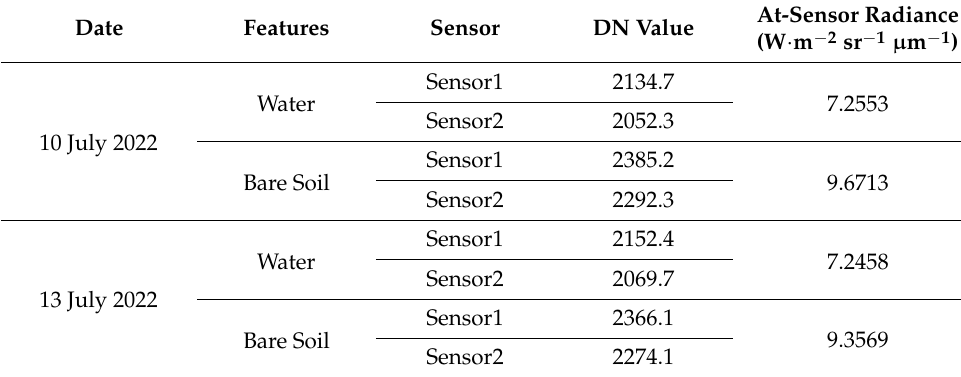
Table 2. ZY1-02E and thermal IR camera parameters.